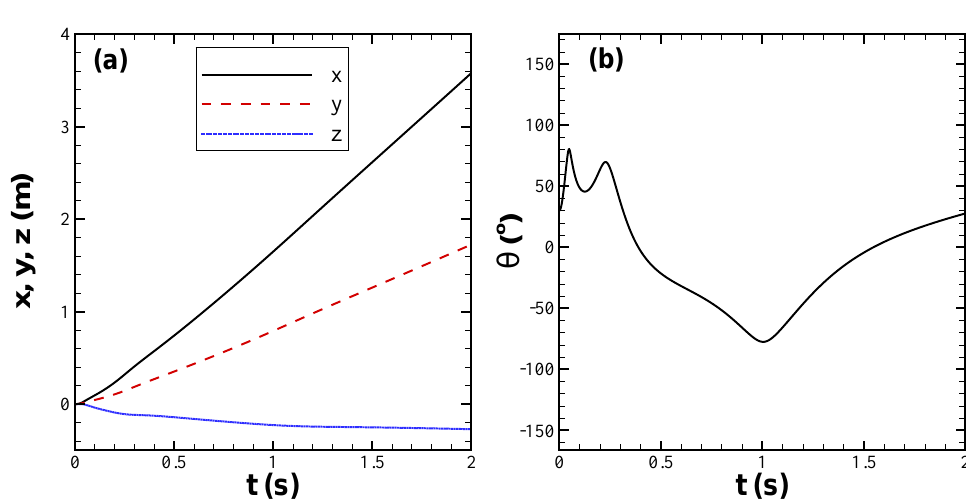
Figure 3 . Trajectory of Sensor Fish for case 2 in two-dimensional uniform flow with the mass center and the geometric center of Sensor Fish overlapped, (a) x(t), y(t), and z(t); (b) θ ( t ) .